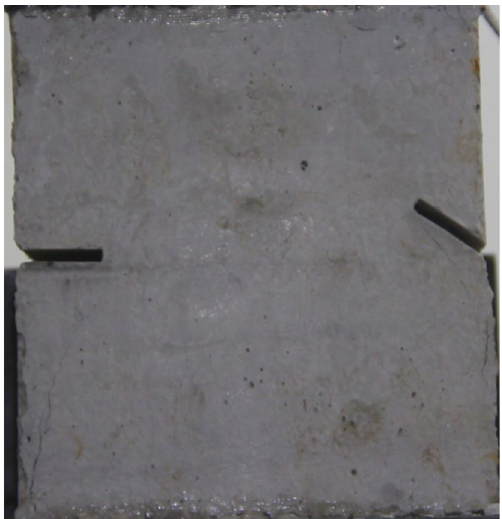
Figure 14. Photograph of a fractured specimen showing tensile crack from the bottom surface caused by compression and anti-tensile wing crack appearing.